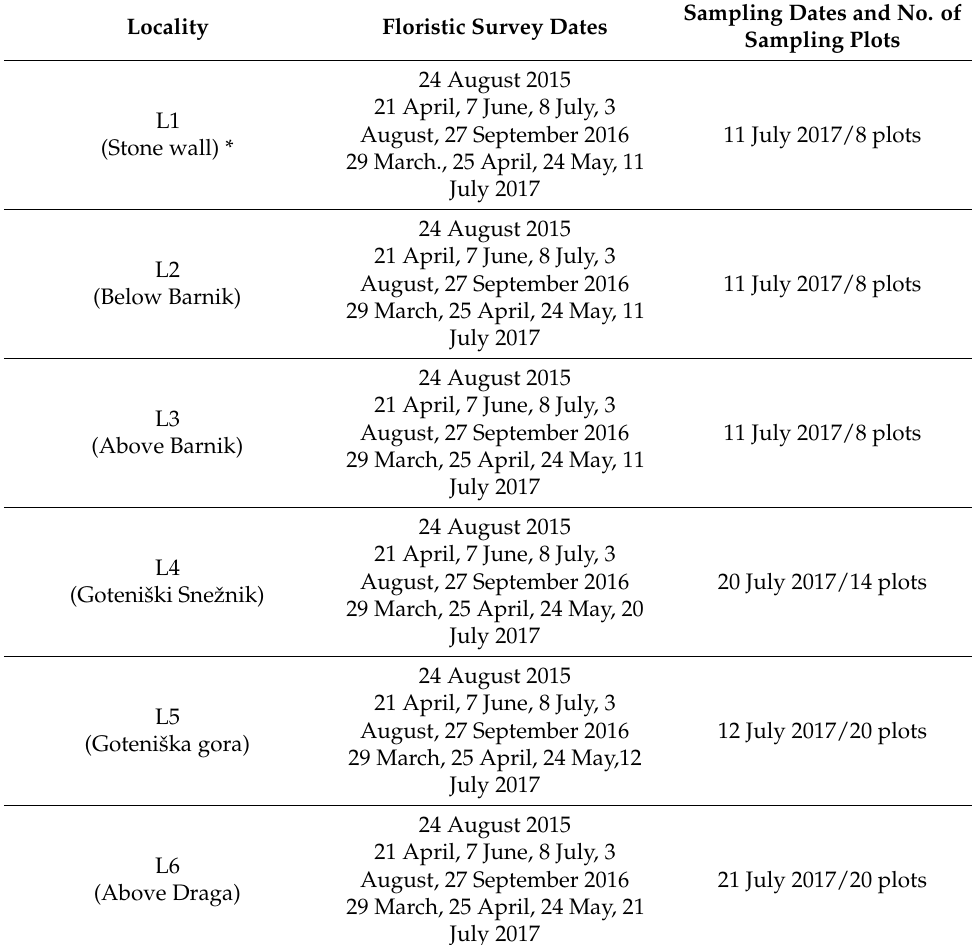
Table 2. Floristic surveys and sampling